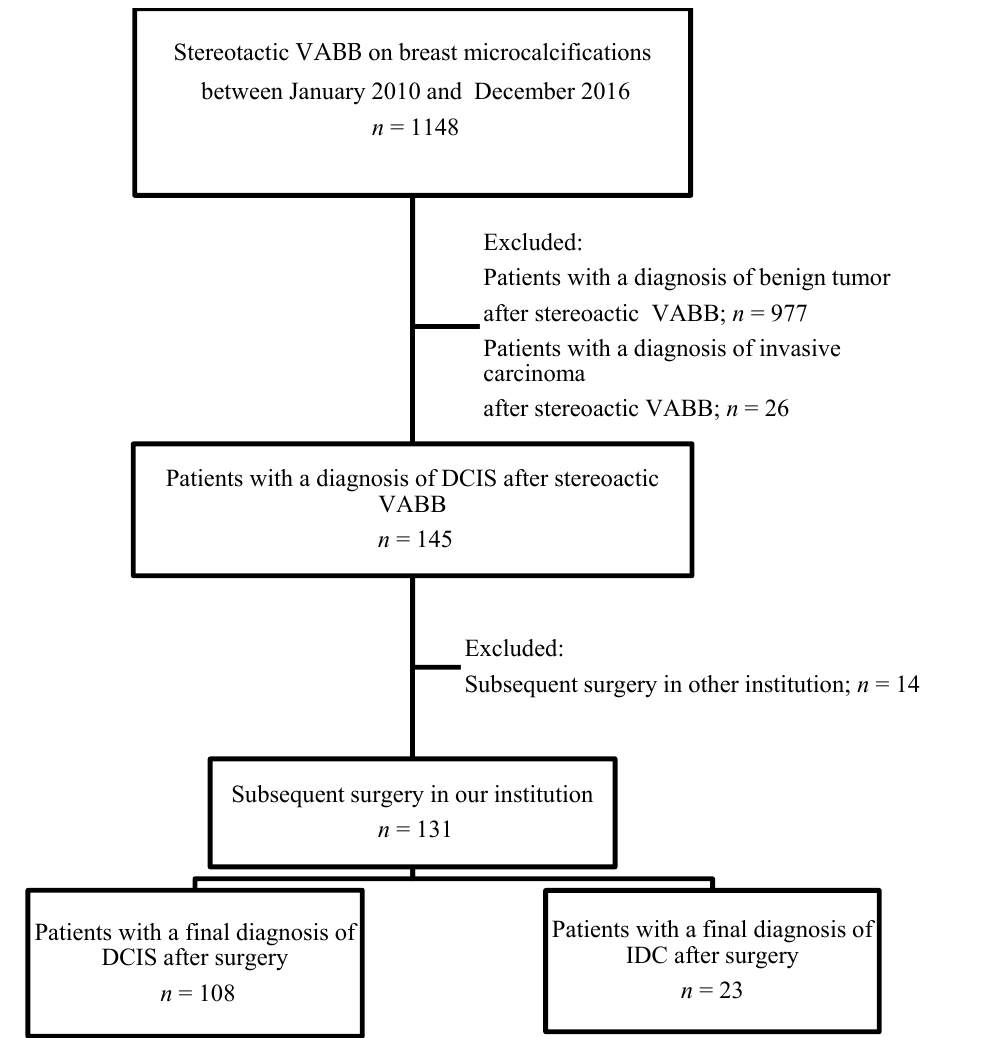
Figure 1. Flow diagram summarizing the total number of vacuum-assisted breast biopsies on suspicious microcalcifications only, and the final diagnosis after surgery. VABB: vacuum-assisted breast biopsy; DCIS: ductal carcinoma in situ; IDC: invasive ductal carcinoma.